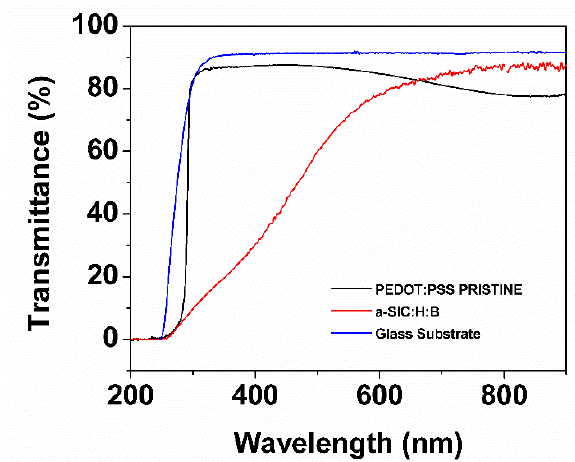
Figure 5. Optical transmittance spectra of an amorphous silicon carbine film doped with boron (a-SiC:H:B), PEDOT:PSS pristine film, and glass substrate.